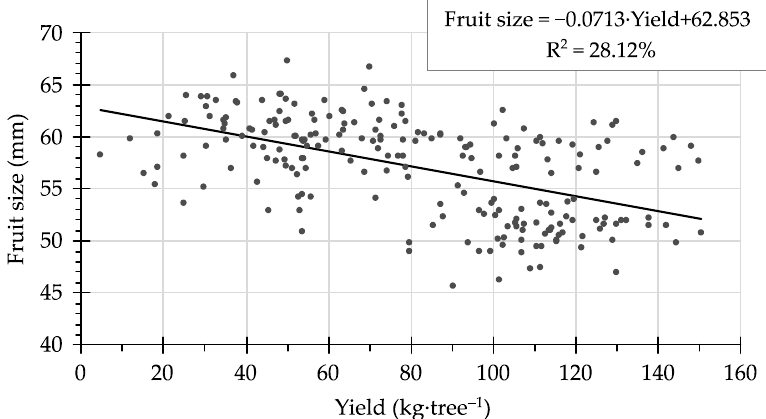
Figure A1. Pruned fresh biomass (kg ∙ tree − 1 ) versus total yield (kg ∙ tree − 1 ) for each pruning strategy (strategies 2–12), in each year under study (2017–2020), and for the 4-year overall. The model equations that describe the relationships between pruned fresh biomass and yield are indicated.